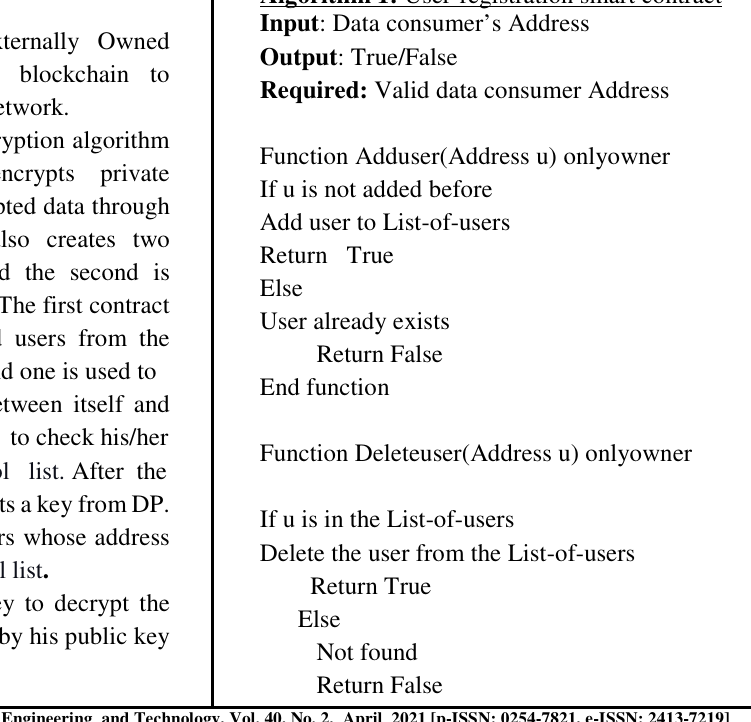
Algorithm 1: User-registration smart